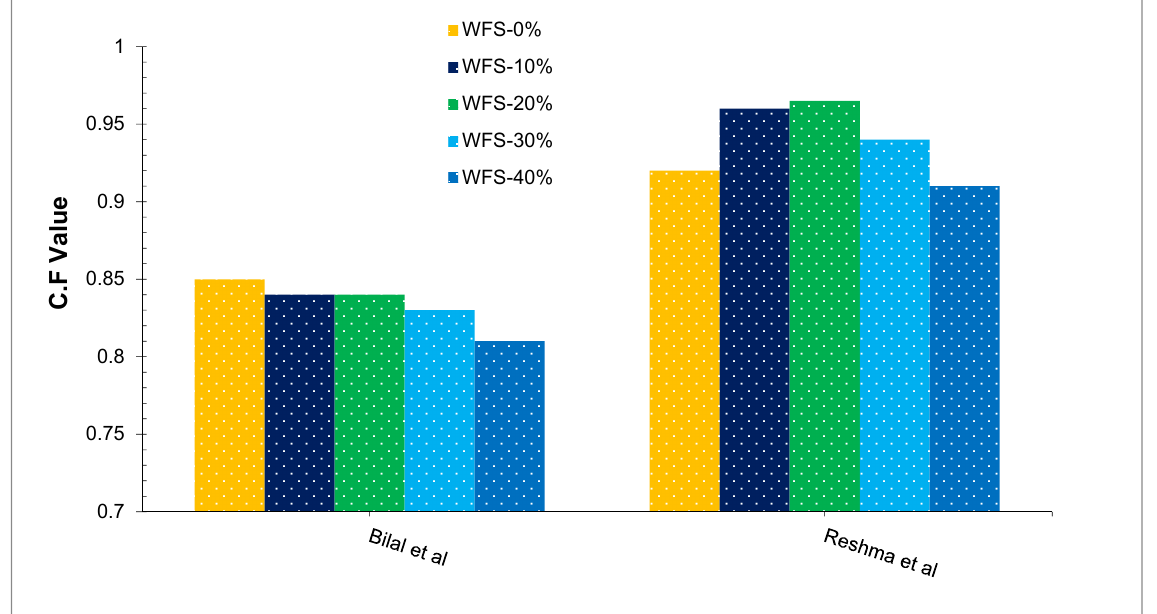
Figure 4. Compaction Factor: Bilal et al. [43] and Reshma et al. [52].